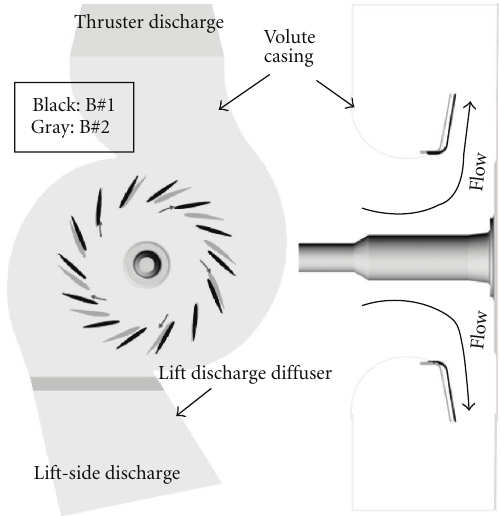
Figure 3: Blade/shroud arrangements for impellers B#1 and B#2.